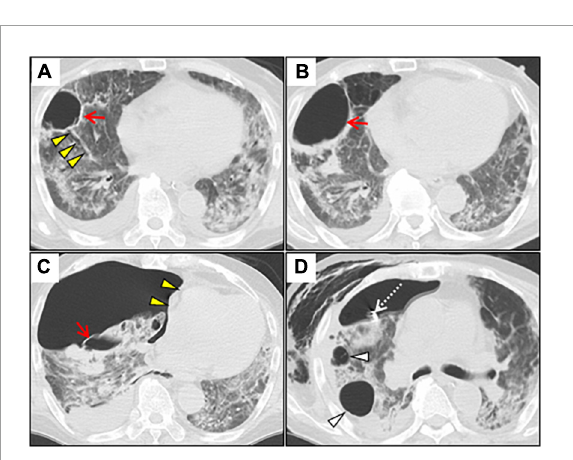
FIGURE2 Serial chest CT images after induction of the invasive mechanical ventilation. (A) Axial chest CT on day 22 shows a lung cyst formation (red arrow) at the right S8 segment. Note the segmental bronchus connecting to the lung cyst (yellow arrowheads). (B) Chest CT on day 41 shows the gradually expanded cyst with air-fluid level, and wall thickening secondary to lung suppuration (red arrow). (C) Chest CT on day 43 shows a huge right-sided pneumothorax with mediastinal shift (yellow arrowheads). Note the collapsed cyst in the right segment 8 (red arrow). (D) Chest CT on day 51 shows residual air leaks after chest tube drainage (white dotted arrow), extending massive subcutaneous emphysema, and further enlargement of other lung cysts (white arrowheads). CT, computed